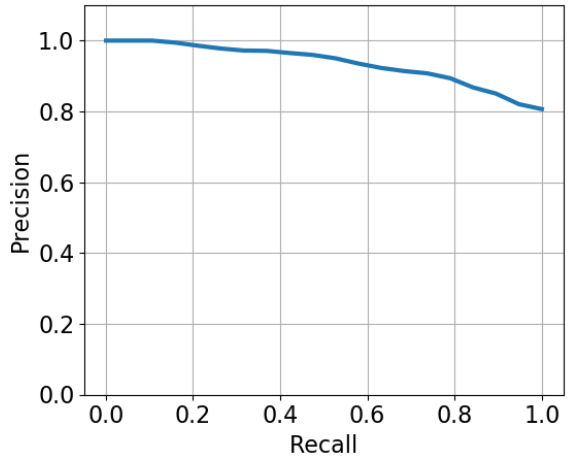
Figure 11. The average precision-recall